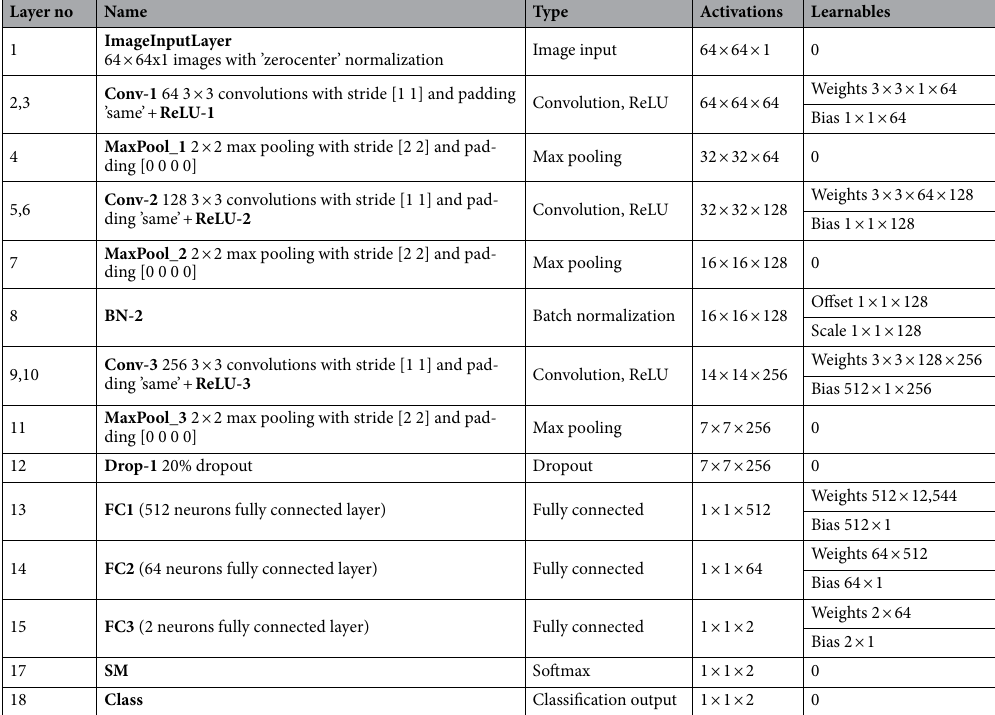
Table 9. Detail of learnable parameters with DL architecture